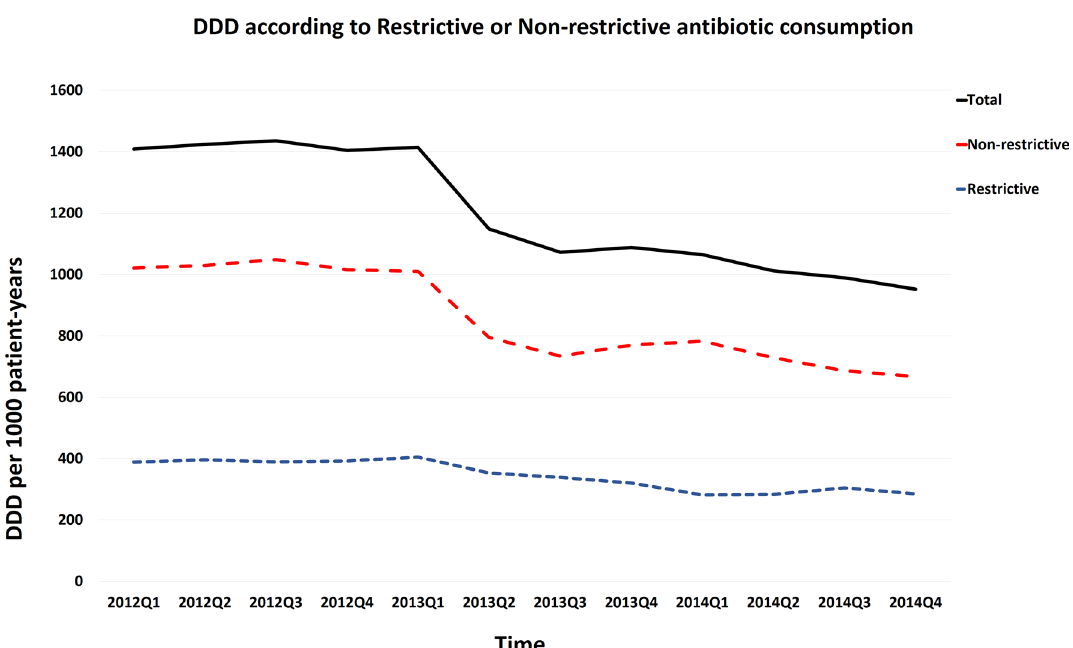
Figure 4. Trends of antibiotic consumption according to restrictive or non-restrictive antibiotics. Both restrictive and non-restrictive antibiotics showed a decreased trend of antibiotic consumption through the study